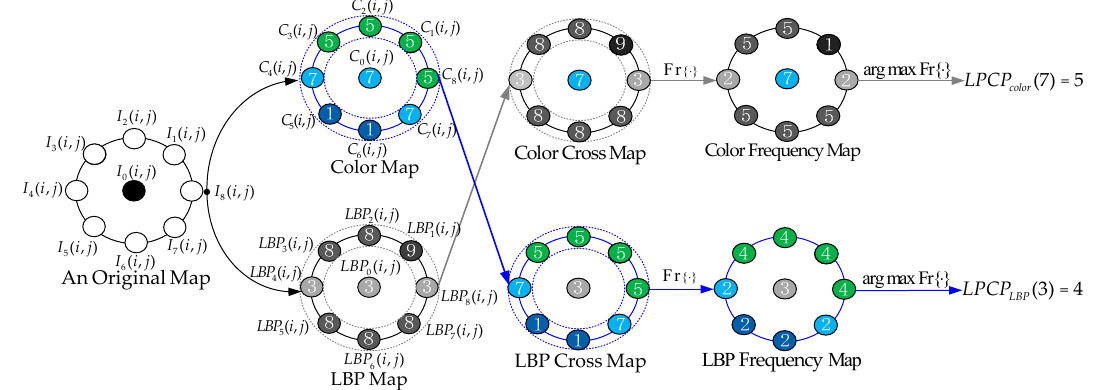
Figure 4. Schematic diagram of the local parallel cross pattern (LPCP).